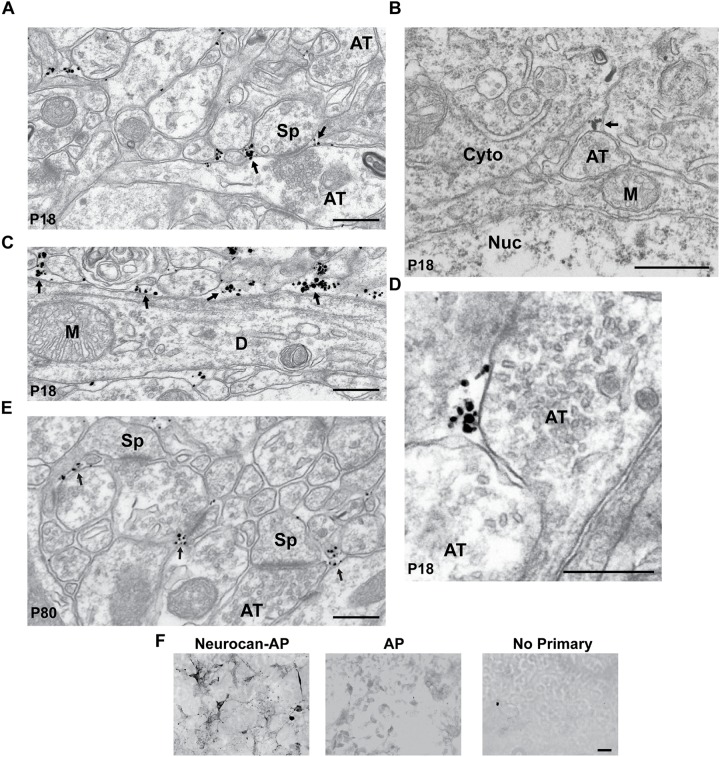
Localization of Neurocan in mouse medial frontal cortex (MFC) by immunogold labeling and electron microscopy. (A) Electron micrograph of MFC layer 2/3 at P18, showing immunogold labeling of Neurocan near the plasma membrane adjacent to a spine (Sp) and axon terminal (AT; arrows). (B) Neurocan labeling in the extracellular space near an axon terminal (AT; arrow) at P18 [Nucleus (Nuc) and cytoplasm (Cyto)]. (C) Accumulation of Neurocan (arrows) in extracellular space and along the plasma membrane of a dendrite (D) at P18. Mitochondria (M) were unlabeled. (D) Neurocan labeling adjacent to axon terminals (AT) at P18. (E) Neurocan labeling at neck of spine (Sp) and near excitatory synapses (arrows) at P80. Scale bar = 1 μm. (F) Validation of Neurocan antibody specificity by immunoperoxidase staining of COS-7 cells transfected with Neurocan-AP or AP alone in the APtag5 vector, using Neurocan antibodies or no primary antibody. An antibody dilution series was carried out in pilot experiments. Scale bar = 50 μm.